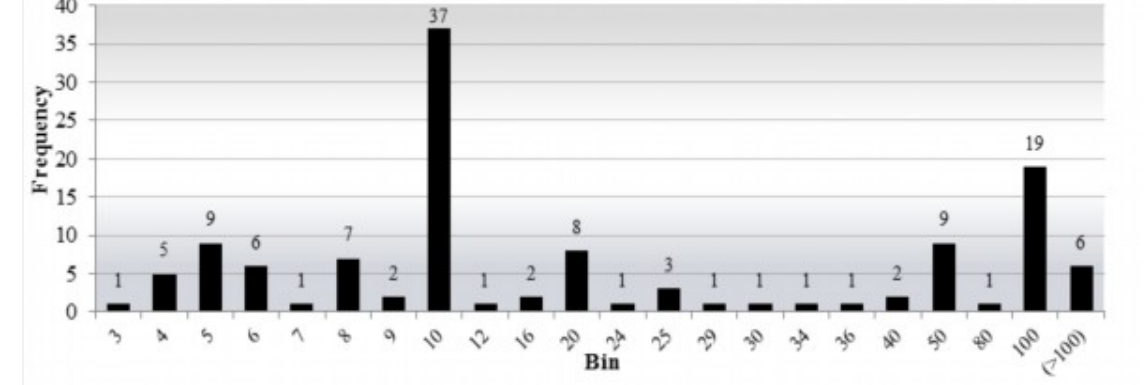
Fig. 4: Number of reverse stock splits according to swap rate